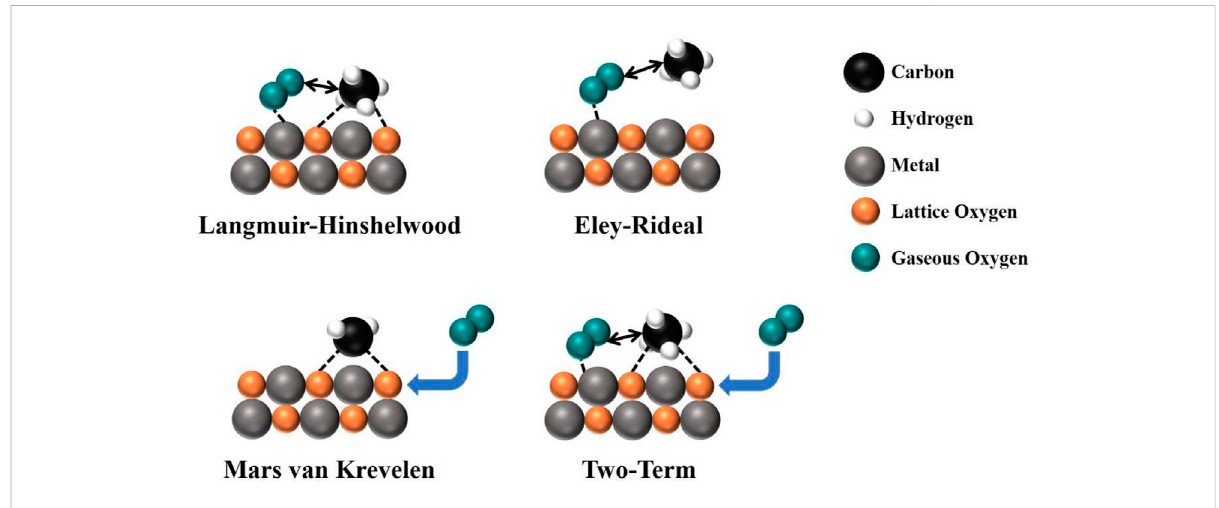
FIGURE 2 The reaction mechanism diagram of